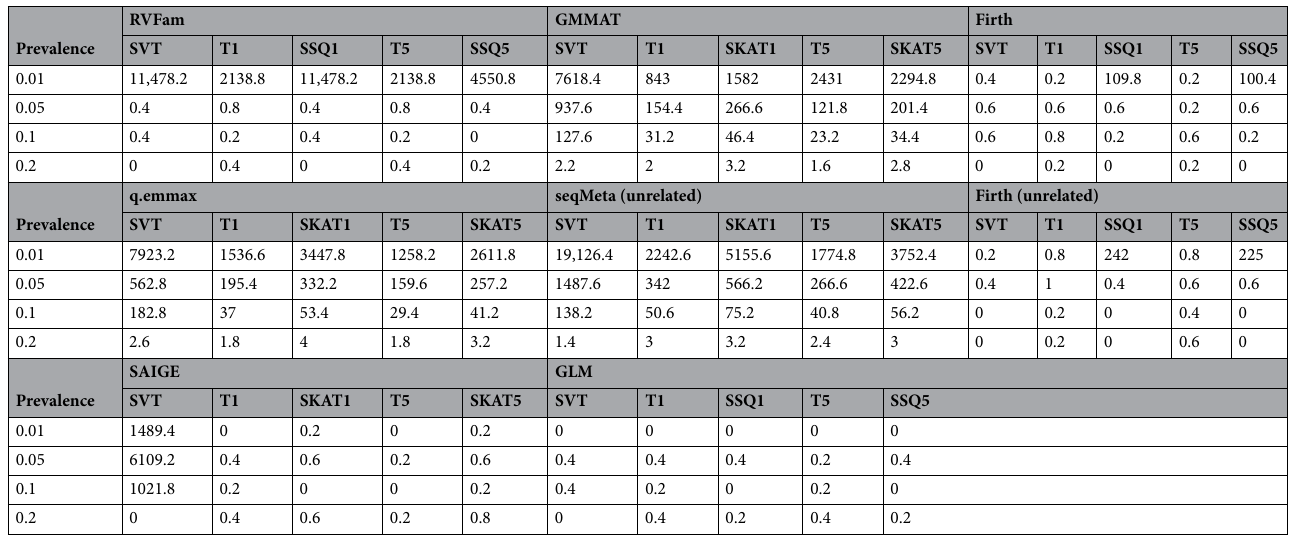
Table 1. Calibrated type I error rate (Type I error rate was computed by total number of SNPs/genes that passed genome-wide significance threshold in 100 replicates divided by total SNPs/genes in 100 replicates, which has been calibrated by dividing the significance threshold. A value greater than 1 indicates inflation) of the first simulation study. Genome-wide significance level for single variant tests (SVT) = 2.027E−7; for gene- based tests = 1.876E−6. Methods with “unrelated” are those applied to unrelated samples, all other approaches were applied to related samples. T1/T5, SSQ1/SSQ5 and SKAT1/SKAT5 denote the three gene-based tests